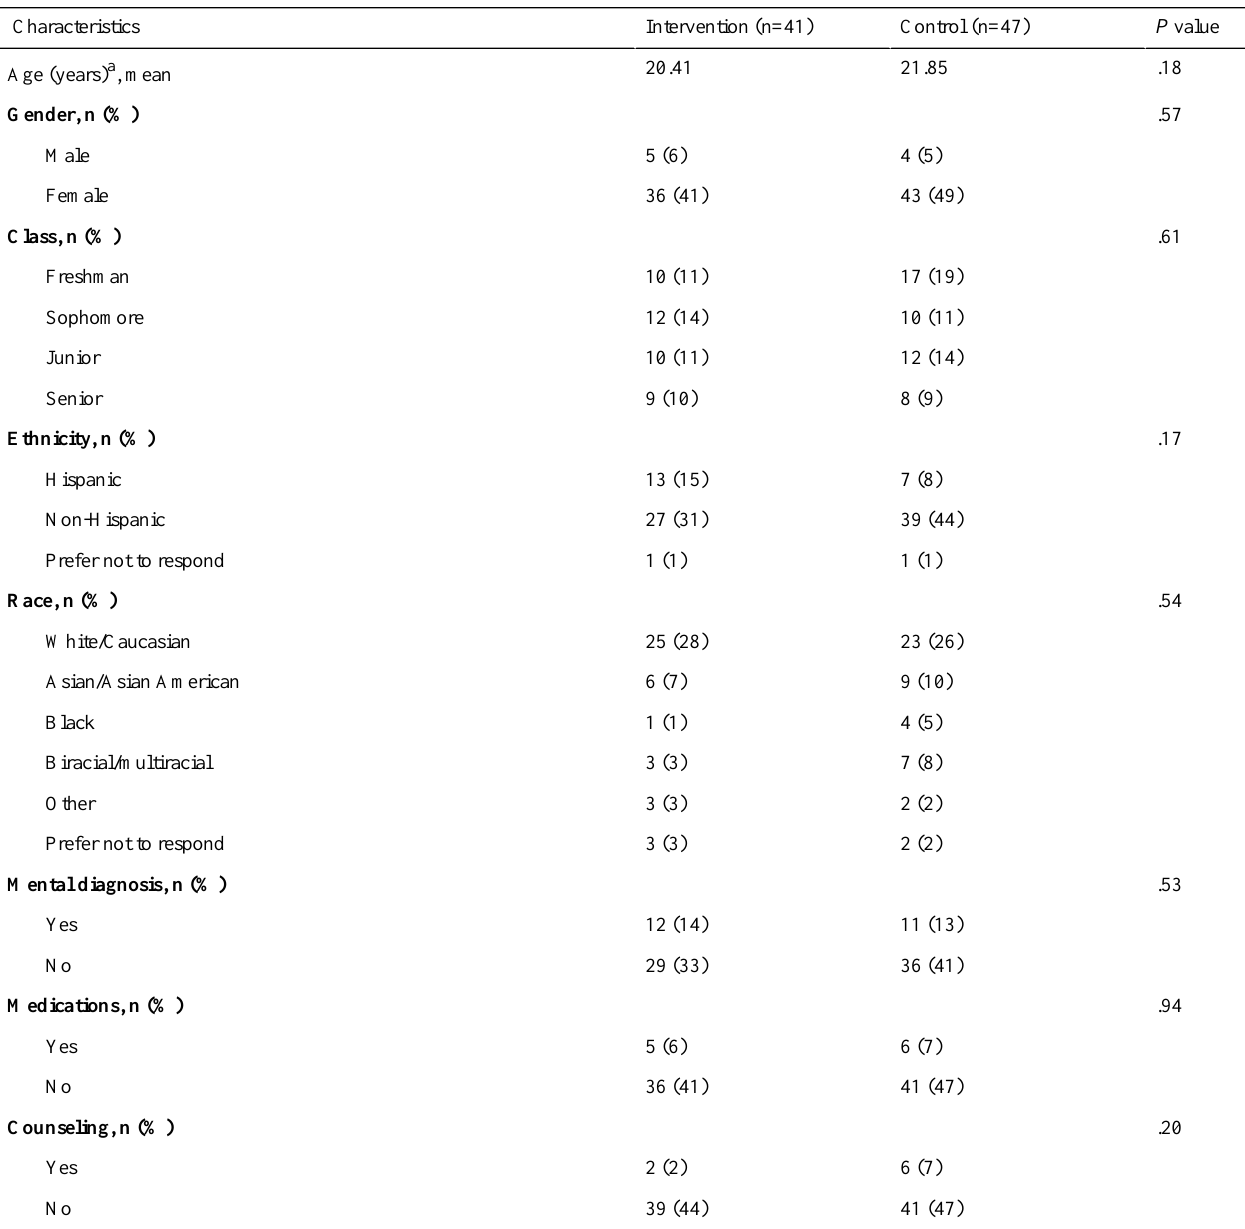
Table 1. Baseline characteristics of the study participants